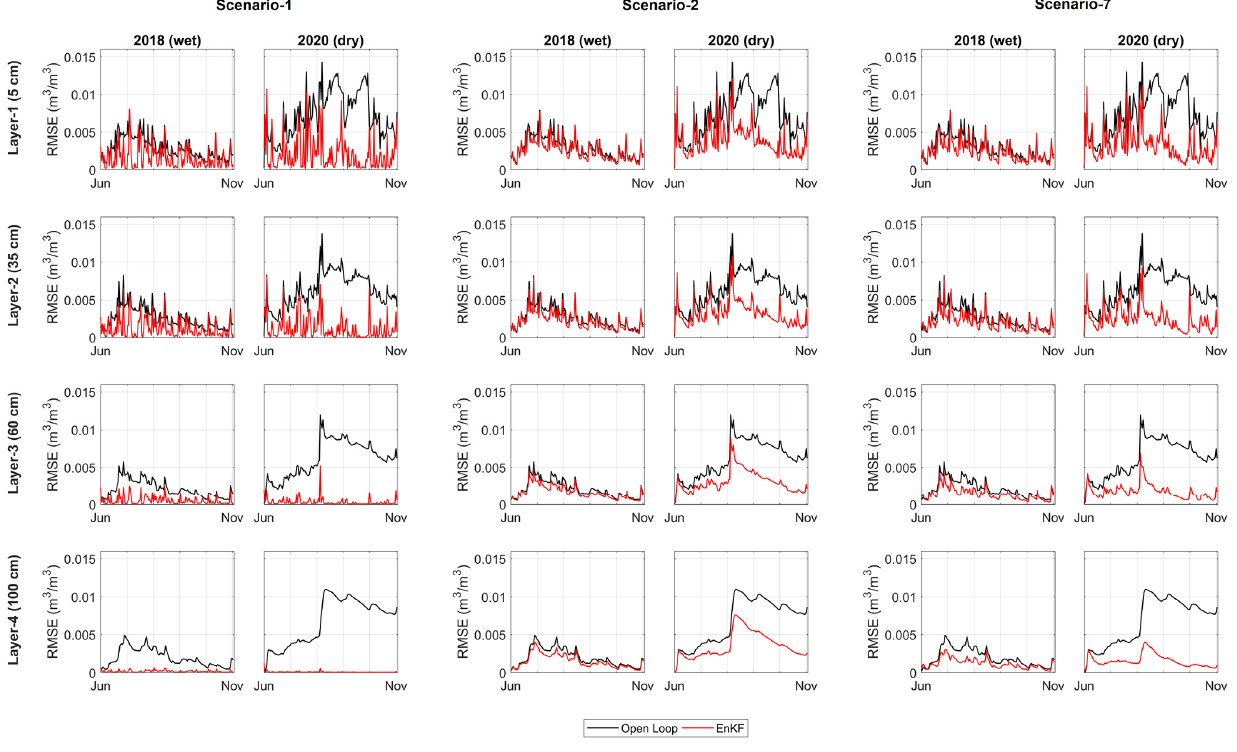
Figure 6. Temporal distribution of basin-averaged soil moisture simulation errors for all soil layers and for scenarios 1, 2 and 7.